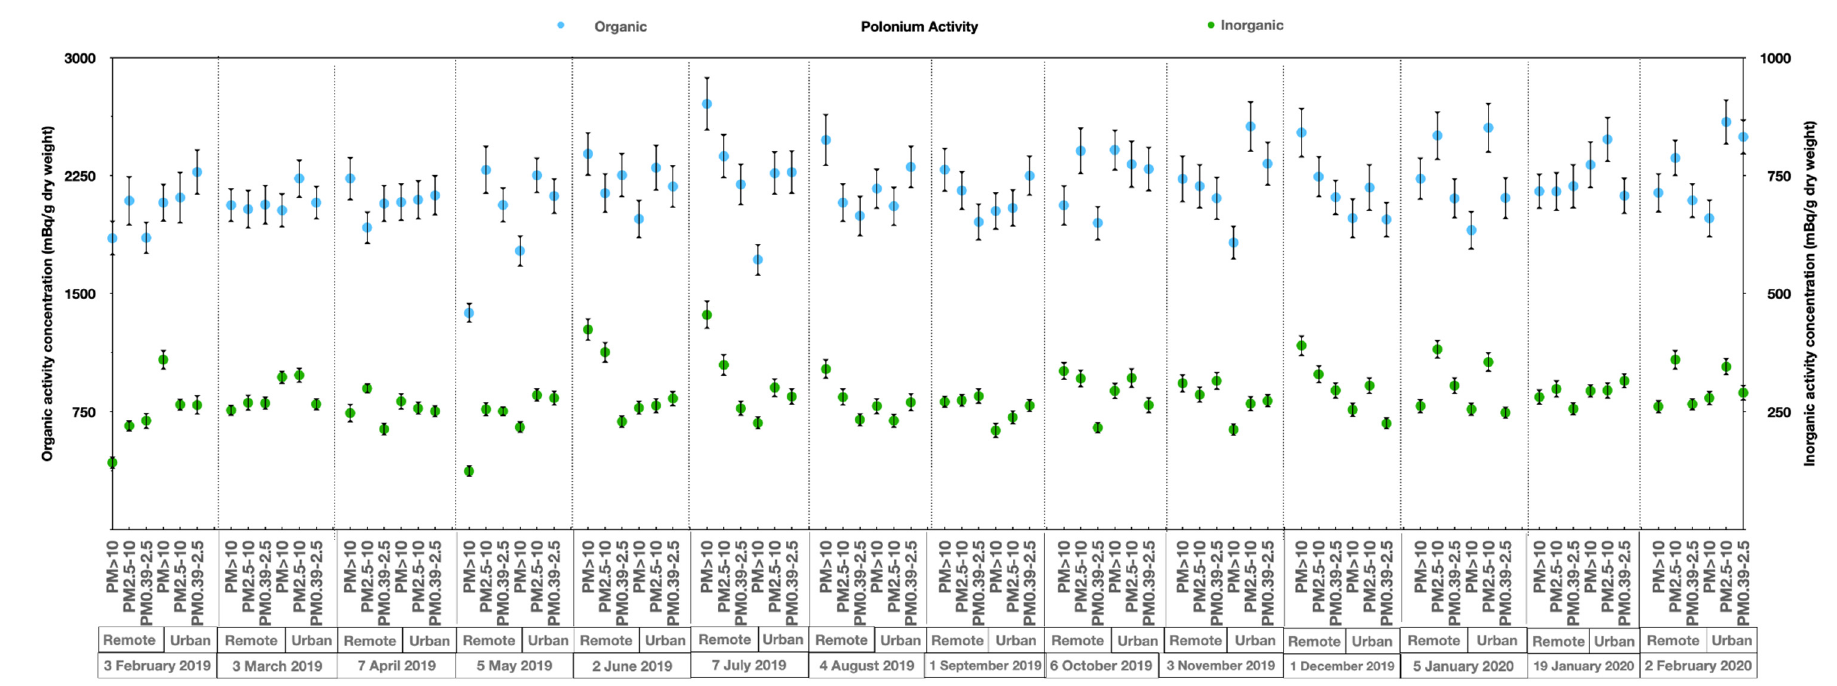
Figure 4. Polonium ( 210 Po) concentrations in the organic and inorganic components of different aerosol size fractions at both locations. The samples were collected from February 2019 to February 2020; this 210 Po study involved 42 samples.